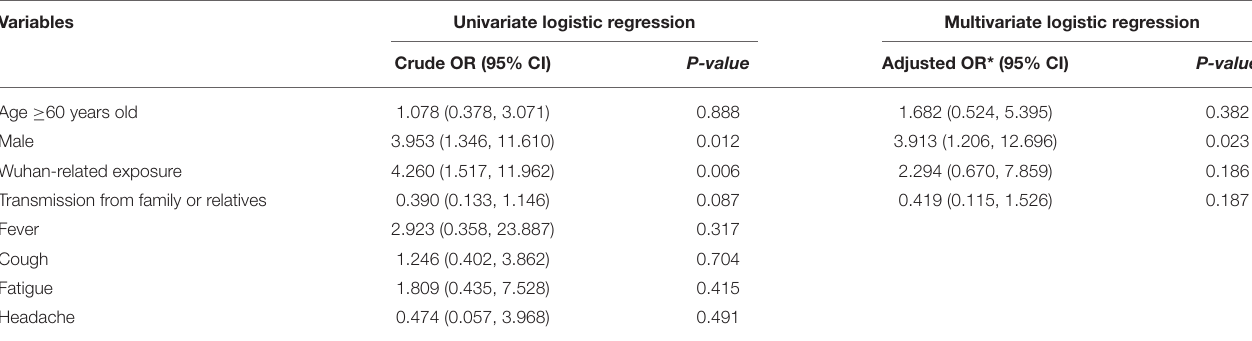
TABLE 3 | Epidemiological factors associated with severe COVID-19 in